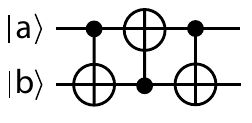
Figure 11: Two-qubit swap